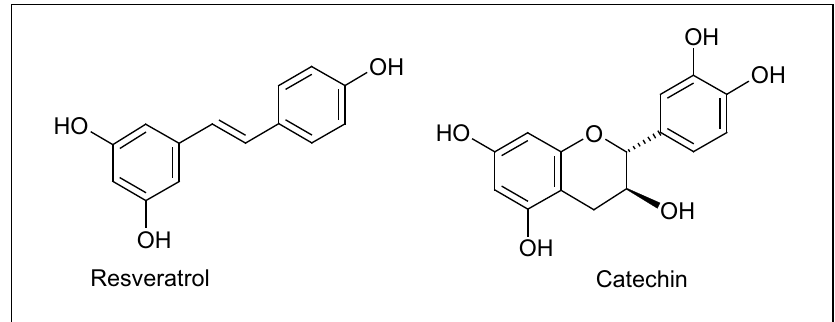
Figure 10. A stilbene (resveratrol) and a flavonoid (catechin) typically present in grape